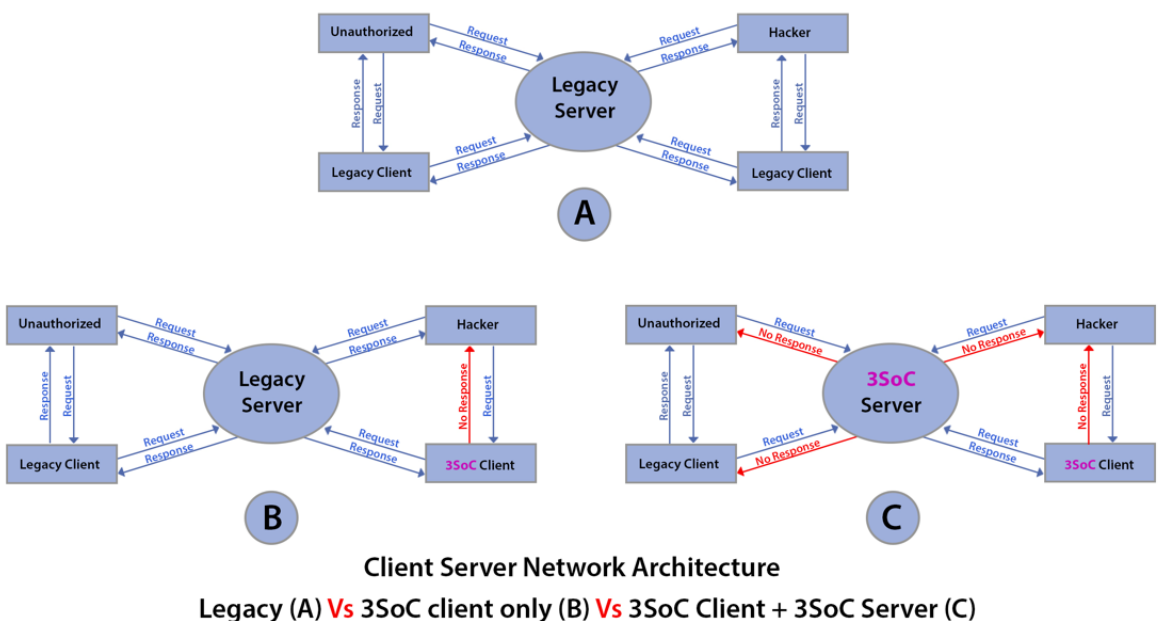
Figure 6. Three scenarios of client–server network architecture: ( A ) legacy, ( B ) 3SoC client only, and ( C ) 3SoC client + 3SoC server (intranet).